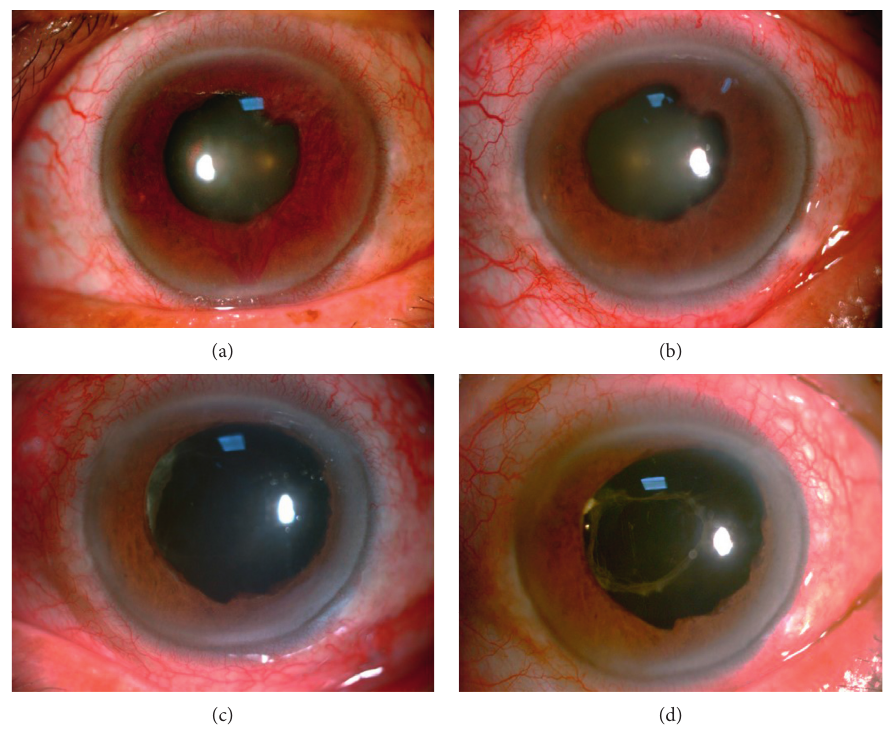
Figure 3: Anterior segment photography of an NVG patient before and after the combined treatment. (a) Massive neovessels and ectropion uveae were observed on the iris and the pupil prior to surgery. (b) The same eye 4 days after IVR, showing neovessel regression. (c, d) The same eye 10 days and 3 months after combined surgeries; no return of neovessels was